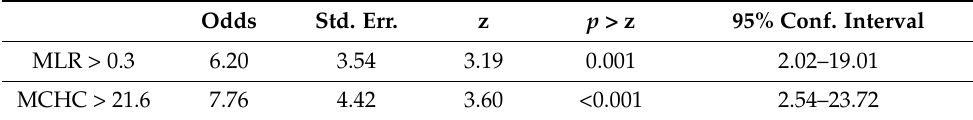
Table 4. Multivariable